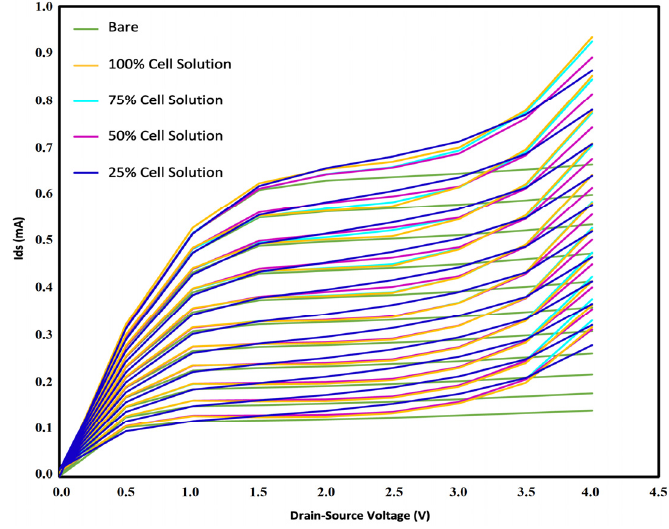
Figure 14. The sensor response to different concentrations of cell solutions in comparison to bare condition.